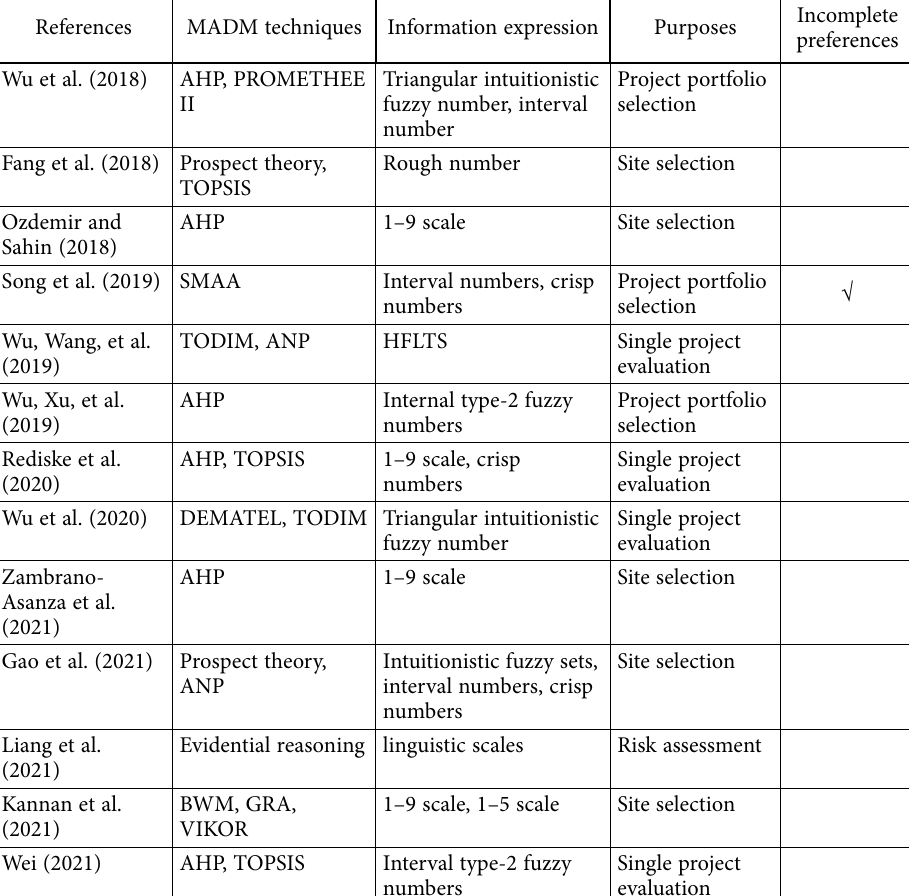
Table 1. A short review of solar PV project investment with MADM